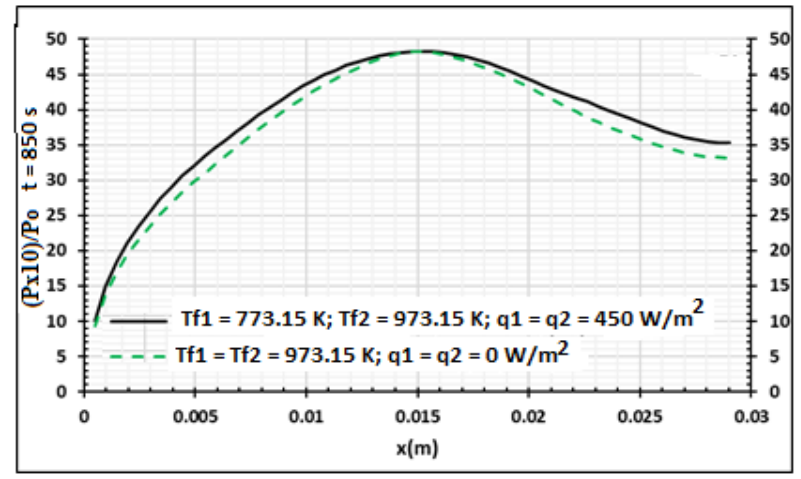
Figure 15. Wood temperature distribution using samples of 30 mm thickness, ρ bo = 700 kg/m 3 . Influence of the contact temperature and heat flux density, t = 850 s.